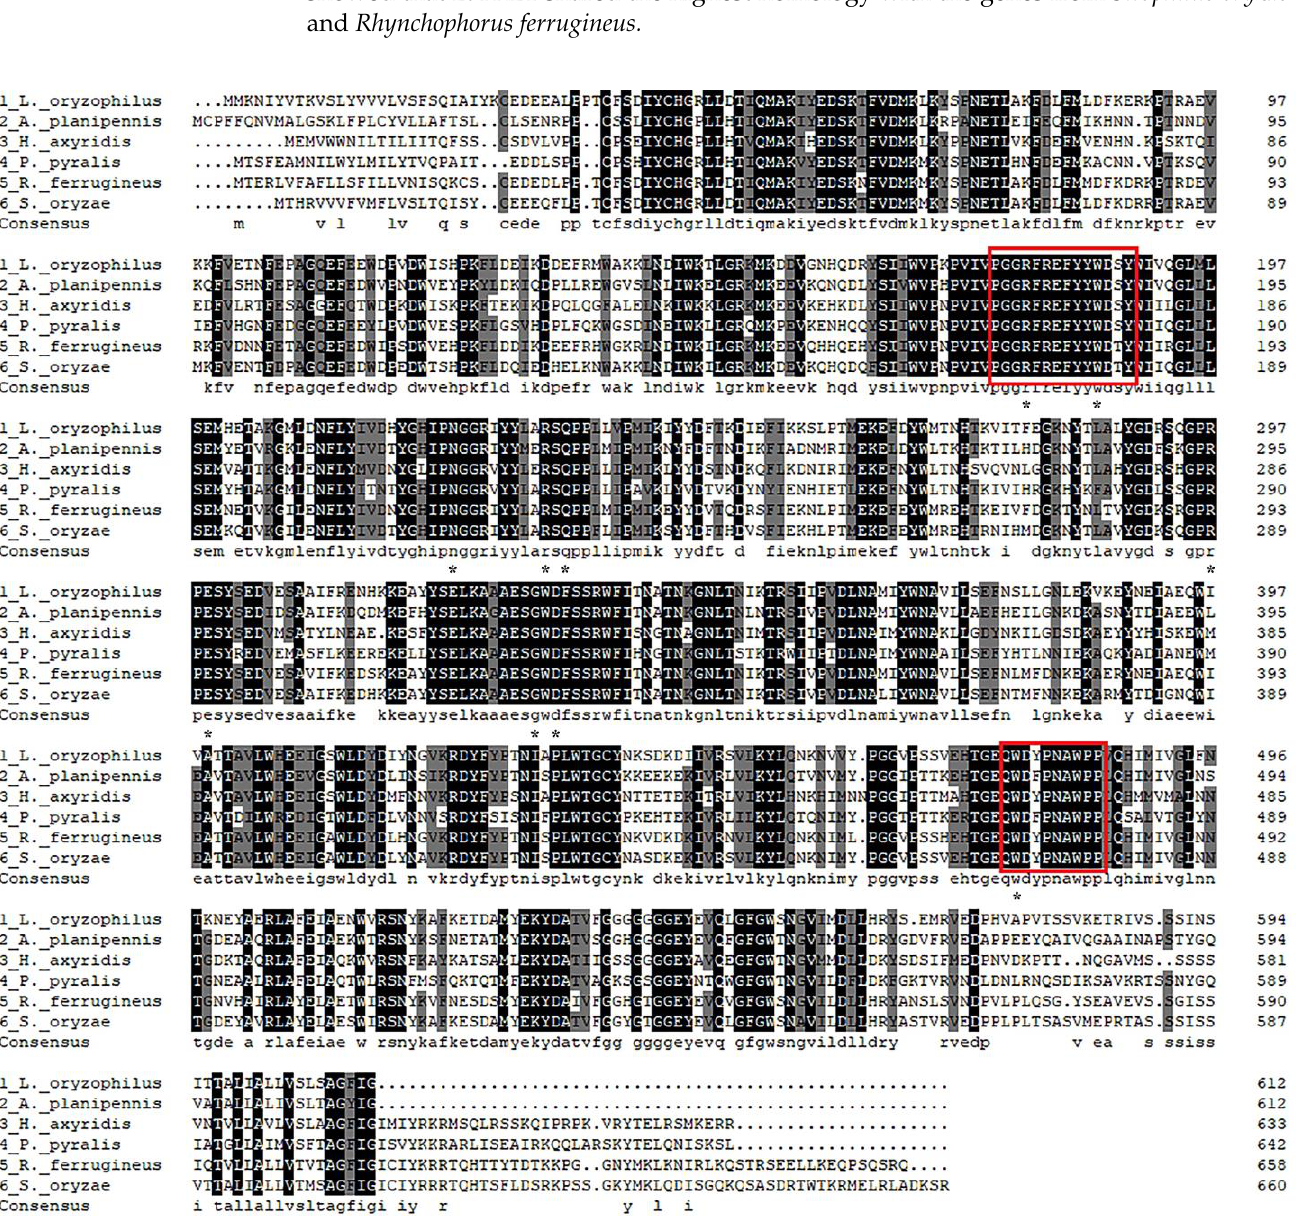
Figure 2. Multiple alignment of soluble trehalase amino acid sequences from Coleoptera insects. The following sequences were utilized in the alignment: ApTRE from Agrilus planipennis (XP_018322659.1), HaTRE from Harmonia axyridis (AOT82130.1), PpTRE from Photinus pyralis (XP_031336857.1), RfTRE from Rhynchophorus ferrugineus (KAF7271780.1), and SoTRE from Sitophilus oryzae (XP 030756586.1). Alignments were performed with ClustalX2. The interaction sites between trehalose and LoTRE1 are indicated by (*). The two signature motifs based on Lissorhoptrus oryzophilus TRE1 are in red boxes in the alignment. Conserved and highly conserved amino acid residues are highlighted in grey and black, respectively.